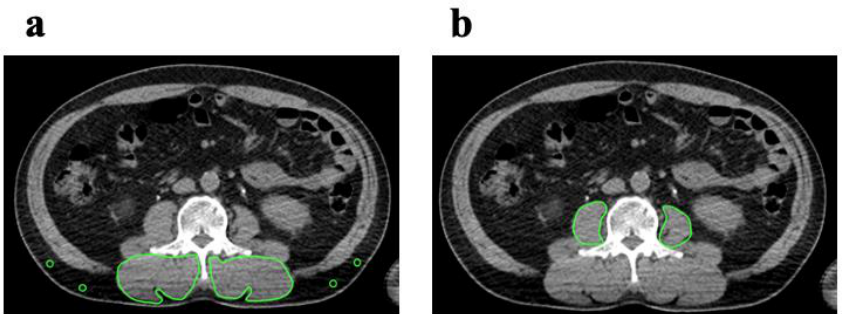
Figure 1. Cross-sectional CT images at the L3 level. ( a ) IMAC was evaluated by dividing the CT value of bilateral multifidus muscles according to the CT attenuation value for subcutaneous fat. ( b ) Subfascial muscle tissue in the multifidus muscle was precisely traced. The PMI was calculated by normalizing the cross-sectional areas to height (cm 2 / m 2 ). CT, computed tomography; IMAC, intramuscular adipose tissue content; PMI, psoas muscle